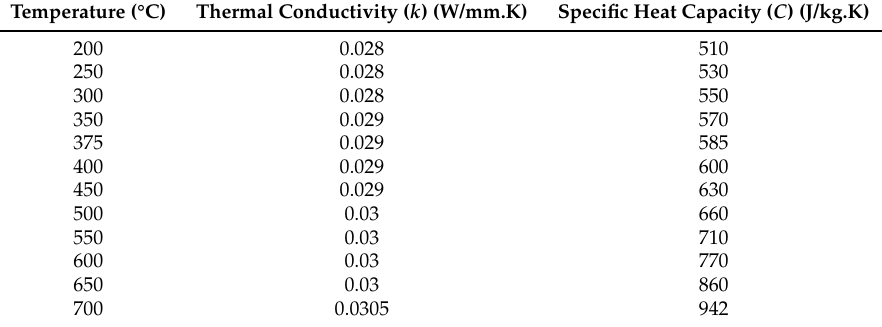
Table 2. A summary of the temperature-dependent material constants (representative of a P91 chrome steel), taken from the work of Yaghi et al . [21], used in the FEA